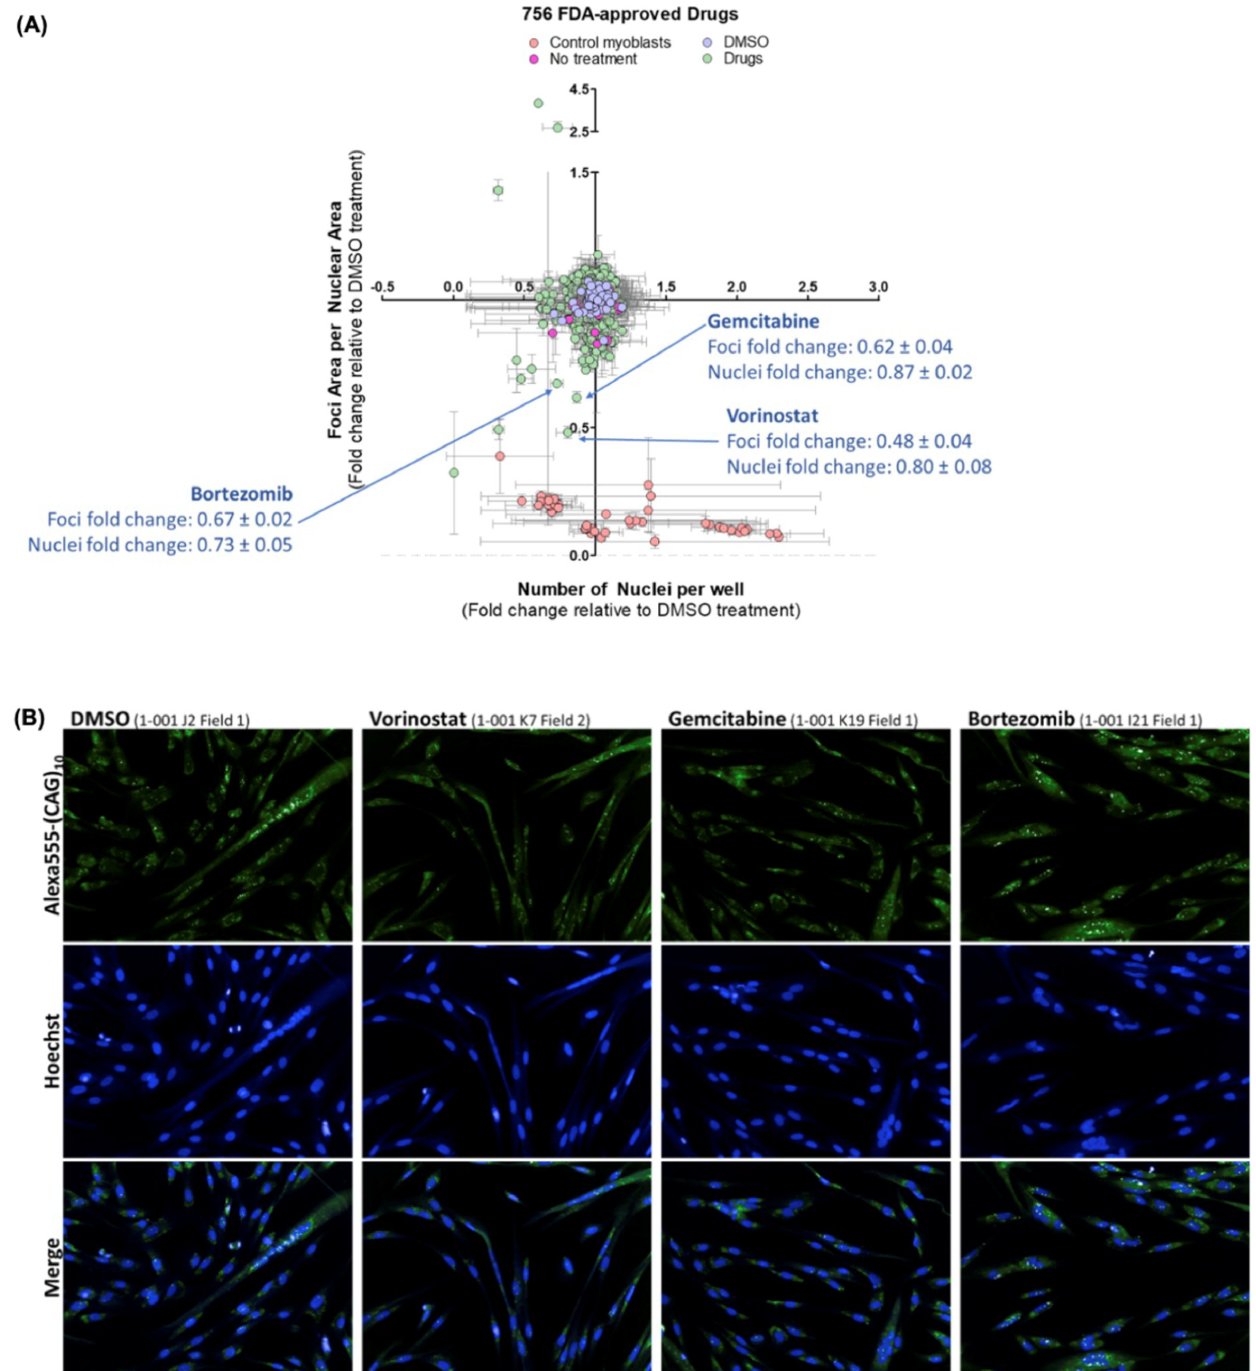
Figure 1. FDA small-molecule screen identified vorinostat, gemcitabine, and bortezomib as potential down-regulators of CUG foci. DM1 3600CTG myoblasts were serum-starved in 384-well plates for 7 days and treated with 2 µM of drugs for 24 h. Post-treatment, cells were stained with Hoechst for DNA and Alexa555-(CAG) 10 for CUG RNA foci. Foci area per nuclear area and number of nuclei per well were quantified using Columbus and normalized to DMSO control data per plate. ( A ) Data is presented as the average fold-change relative to DMSO treatment ( n = 3, error bars represent SD). ( B ) Representative images of top hits for small molecules which reduce foci. Full data set is summarized in Supplementary Table S1.